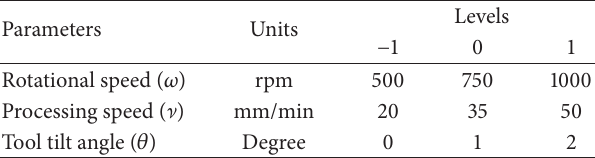
Table 1: Coded and actual values of FSP